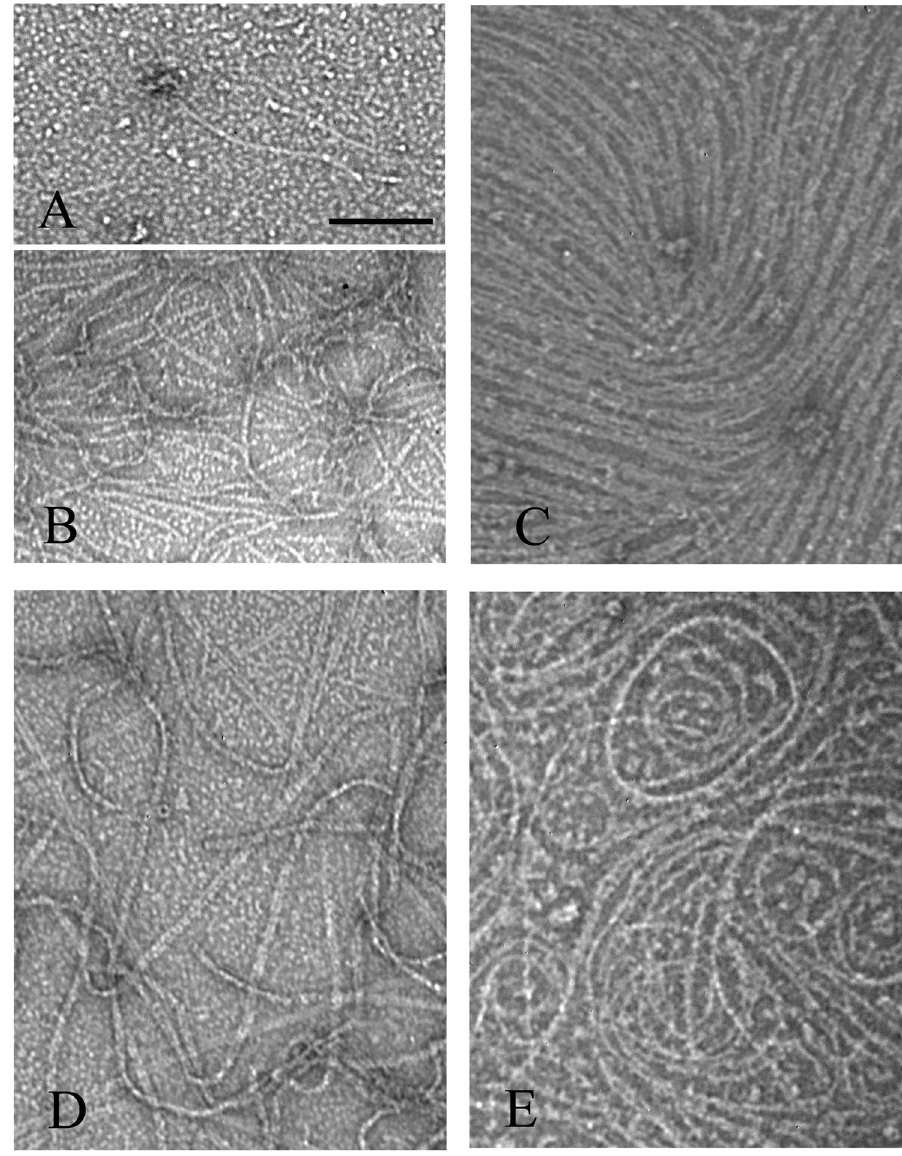
Figure 4. EM images FtsZ and FtsZ-ZipA assembled with EDTA and GTP, pH 6.5 ( A – C ), or in HMK pH 7.5 with GMPCPP ( D , E ). In MEK buffer (50 mM MES, pH 6.5, 100 mM KAc, 1 mM EDTA) plus GTP, a few filaments were assembled with 5 µ M FtsZ ( A ) and more with 10 µ M FtsZ ( B ). 5 µ M FtsZ plus 5 µ M ZipA in MEK assembled abundant thick filament bundles ( C ). In HMK buffer, pH 7.5, in 0.5 mM GMPCPP, 5 µ M FtsZ assembled into long filaments and bundles ( D ). 5 µ M FtsZ plus 5 µ M ZipA in GMPCPP, pH 7.5, assembled into long filaments with a tendency to curve ( E ). Bar represents 100